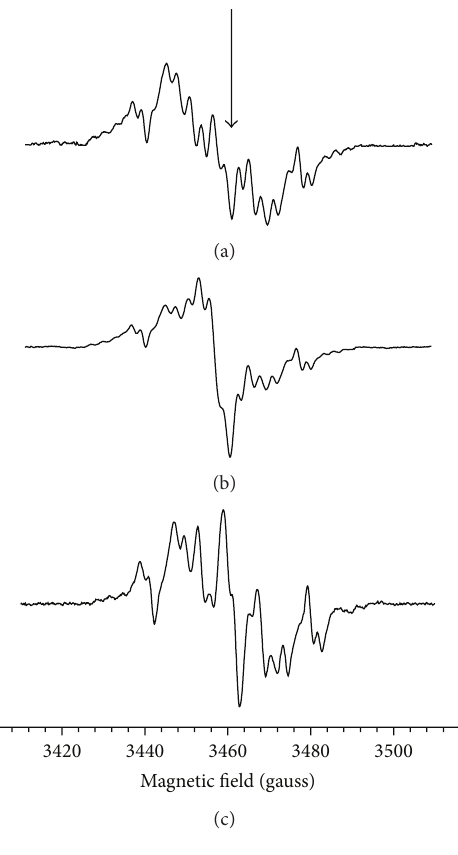
Figure 1: ESR spectra of 100 kGy irradiated samples, (a) pristine UHMWPE powder samples, (b) vitamin E UHMWPE samples, and (c) compression moulded UHMWPE